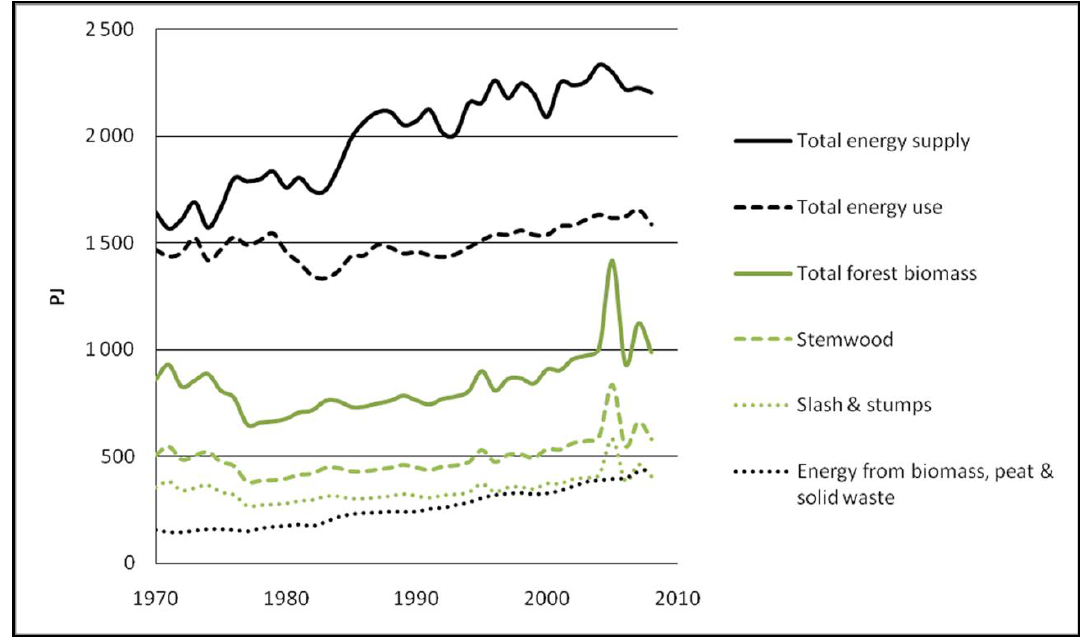
Figure 6. Estimated total bioenergy potential (PJ) in Sweden’s annual forest harvest (1970–2008) in comparison with the total energy supply and use (conversion and distribution losses and losses in nuclear power stations excluded) and the amount of biomass, peat, and solid waste used for energy during the period